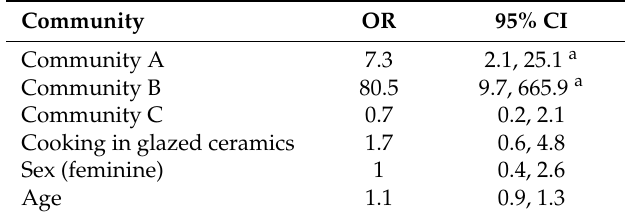
Table 4. Blood lead 1 with cut-off points ≤ 10 µ g/dL and >10 µ g/dL in children.